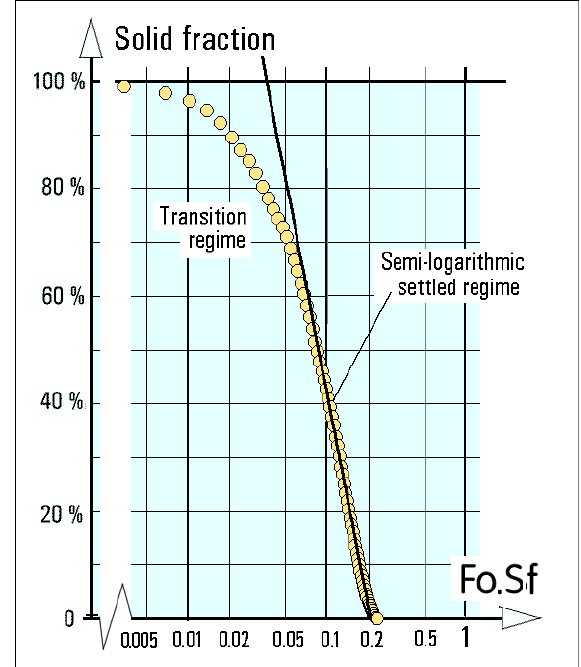
Fig. 22. Time history of melting the n -eicosane solid in the spherical capsule, evaluated from photographs of the surface of the solid (as they are seen in Fig. 20). The time scale is converted into the relative coordinates by evaluating Fourier number Fo and Stefan number Sf. according to Fig. 21. In the substantial part of this diagram, in the settled equilibrium regime, the volume of the remaining solid is governed by the semi-logarithmic law.